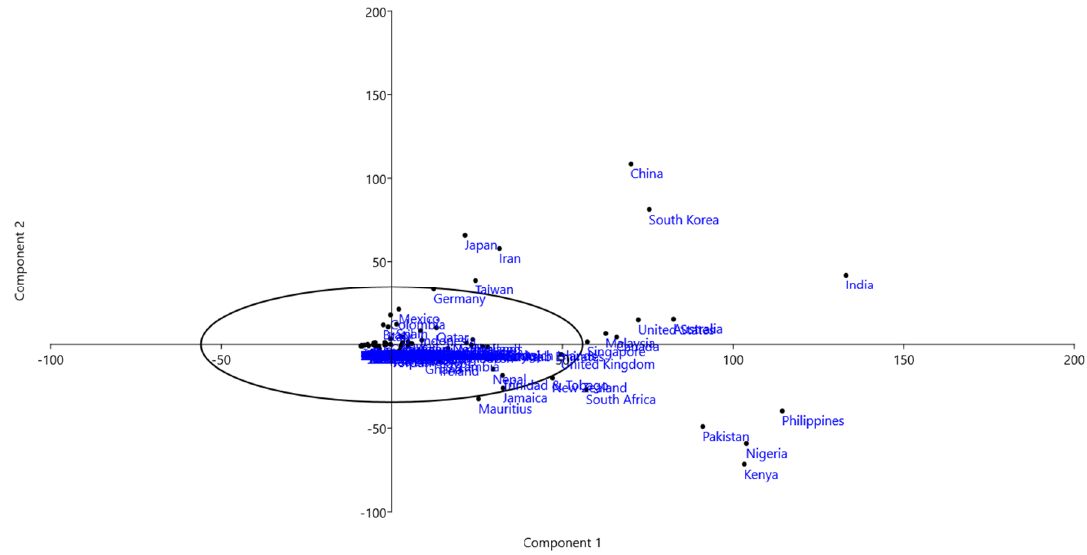
Figure 6. Principal component analysis (PCA) of all the countries associated with phytohormone search queries of all the nine studied phytohormones. PCA show India, United states, Australia, South Korea, China, Malaysia, Japan, etc. fall distantly in one coordinate whereas the Philippines, Nigeria, Kenya, Pakistan, the United Kingdom, South Africa, New Zealand, etc. fall distantly in another coordinate. The countries those fall distantly in the PCA plot show search queries for a greater number of phytohormones while those present in the center has none or zero result. The variance-covariance matrix was used to draw the PCA plot with 1000 bootstrap replicates. The Eigenvalue and variance of the PCA plot can be found in the supplementary data.